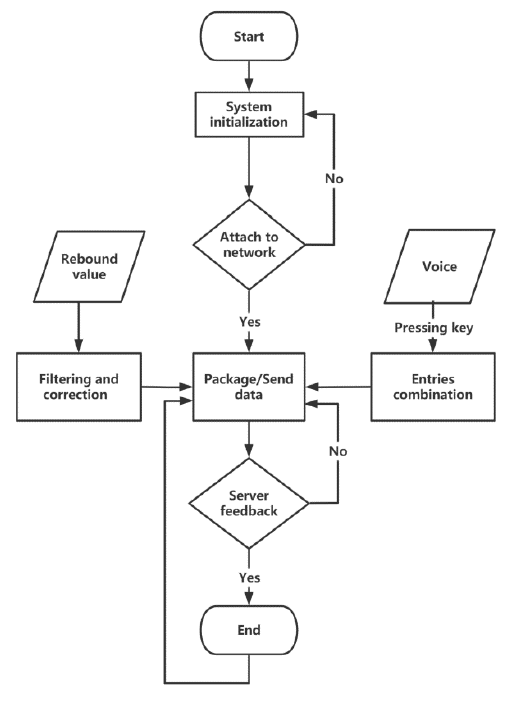
Figure 5. The program flow chart of the MCU.